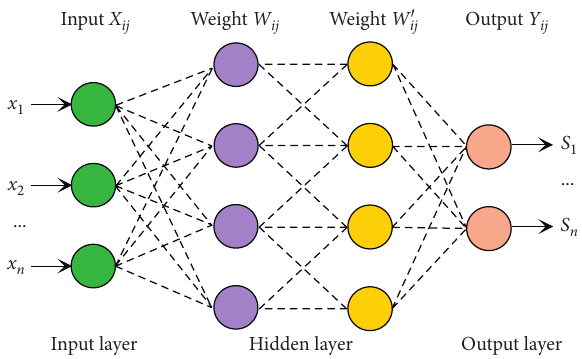
Figure 1: Structure distribution of the BP neural network